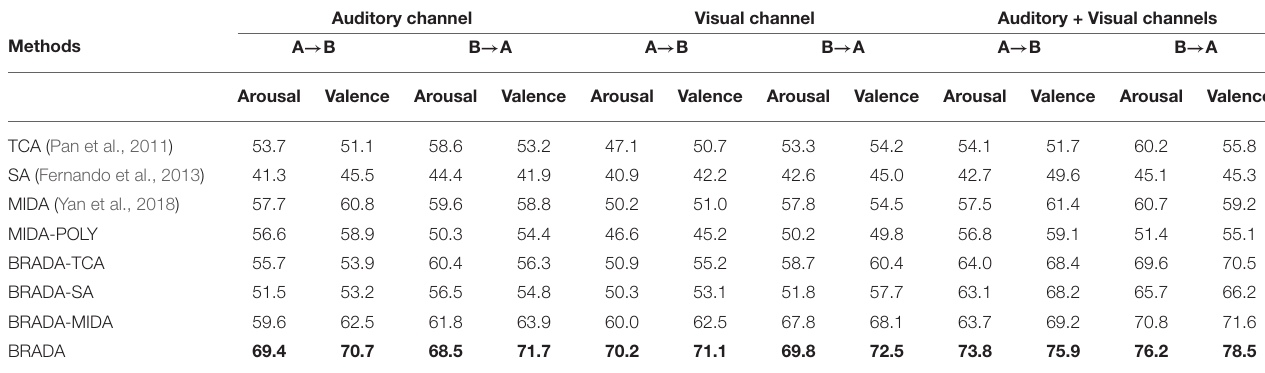
The bold values indicated the highest accuracy obtained.